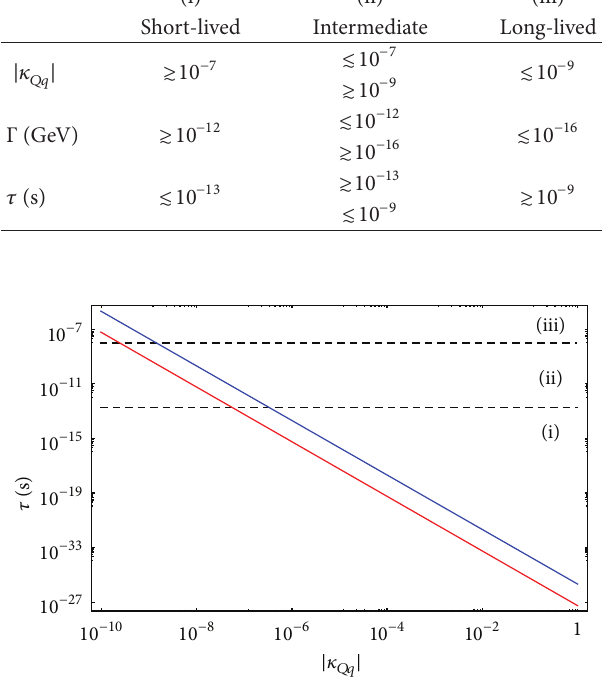
Figure1:Lifetime 𝜏 inseconds( 𝛾𝛽 ≃ 1 )forasequentialheavyquark 𝑄 decaying to the lighter families by emitting a real 𝑊 boson, for = 300 GeV/ 𝑐 2 (in blue) and 𝑚 = 1800 GeV/ 𝑐 2 (in red). The 𝑚 𝑄 𝑄 three regions of interest refer to the conventions given in Table